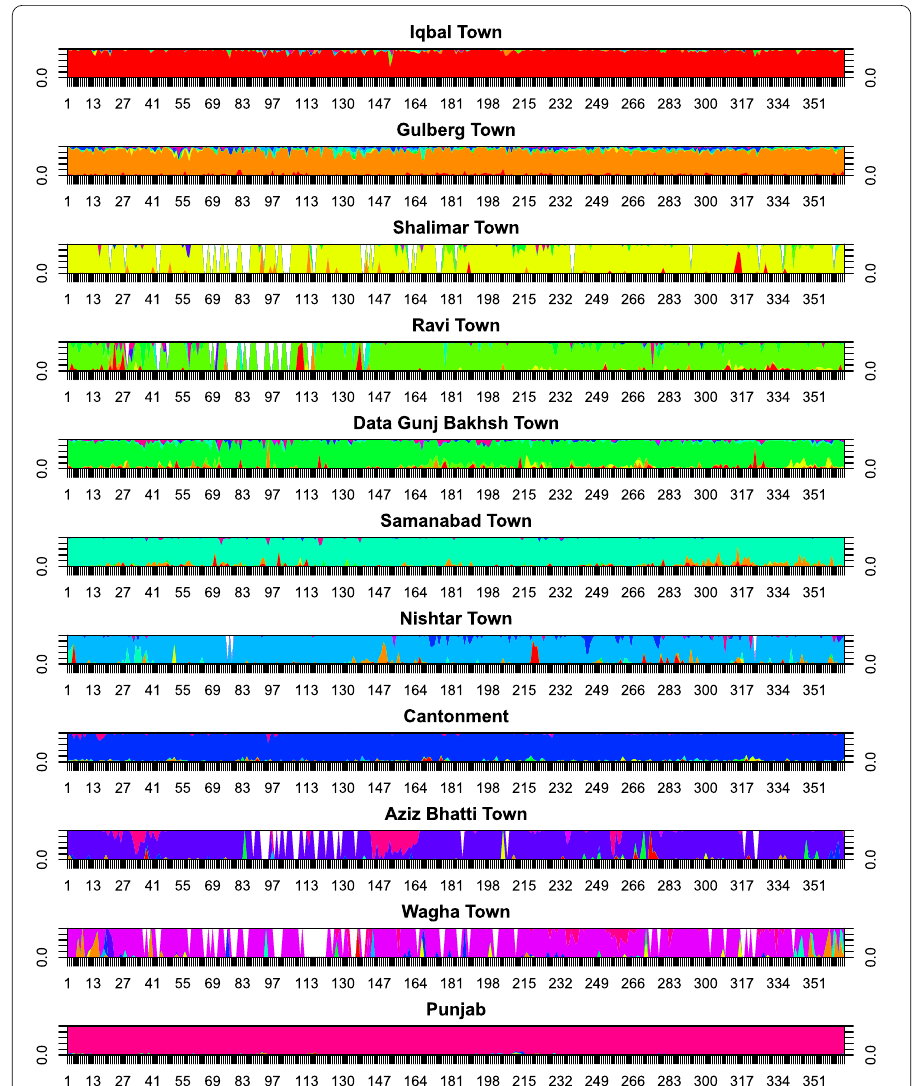
Figure 1 Relative proportion of tweets made in the town indicated in the panel label by residents of every other town. Different colors represent different home location of residents